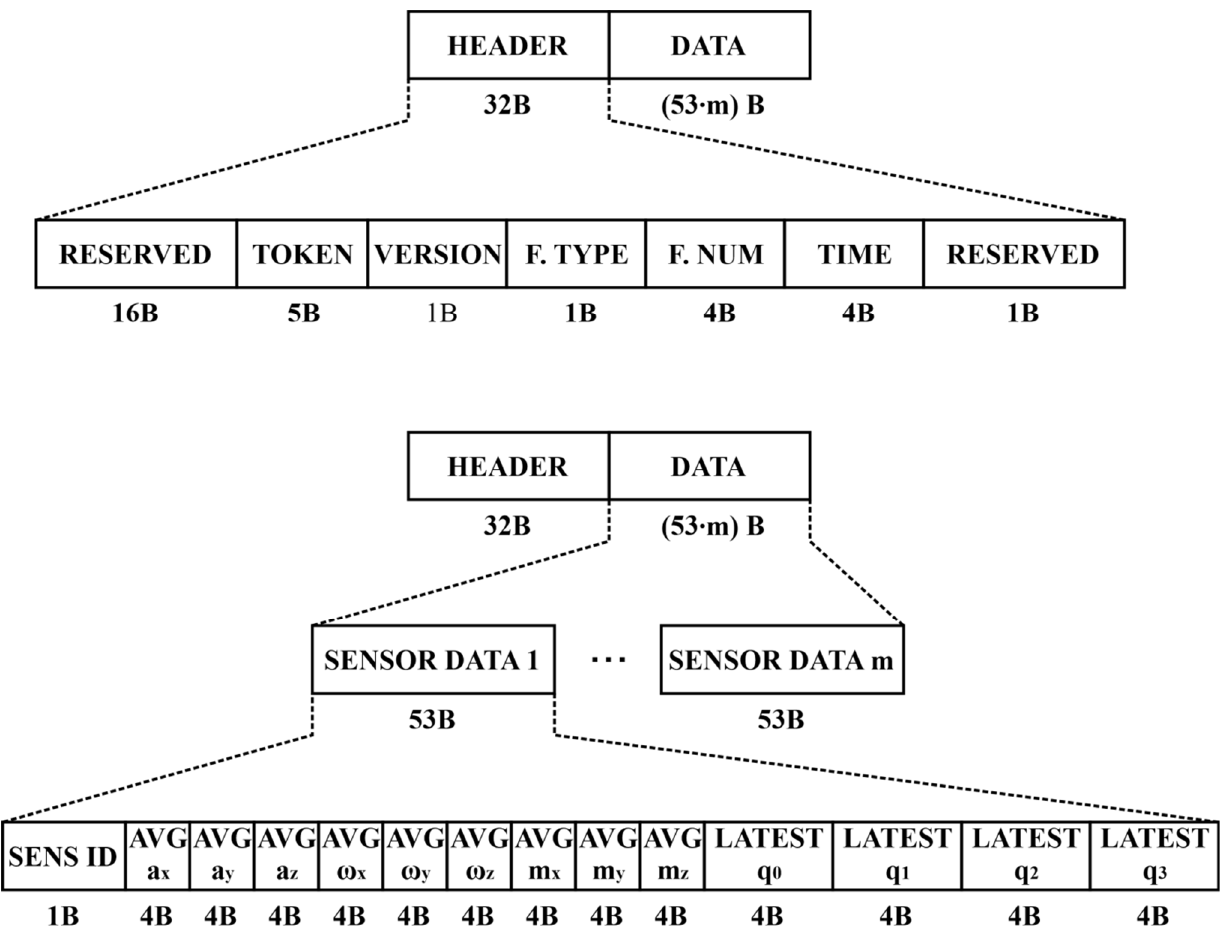
Figure A1. Structure of the WSS data frame.